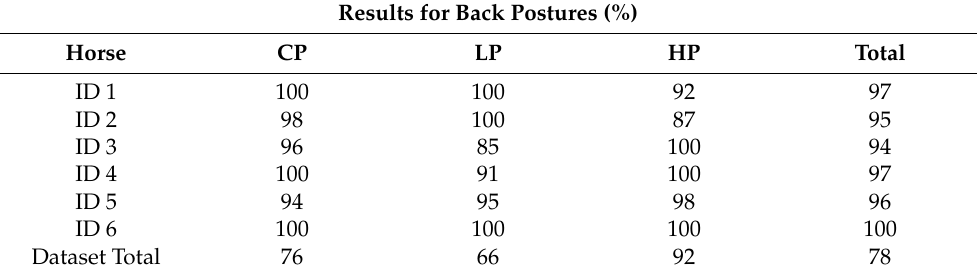
Table 1. The canonical variate analysis (CVA) cross-validated results for back postures of individual horses (ID 1, ID 2, ID 3, ID4, ID 5, ID 6) and group membership (Dataset Total) according to the three feeding positions: on the ground—control position (CP); neck held 15 ± 3 ◦ below withers height with low hay net position (LP); neck held 15 ± 3 ◦ above withers height with high hay net position (HP). Values are expressed as percentages.